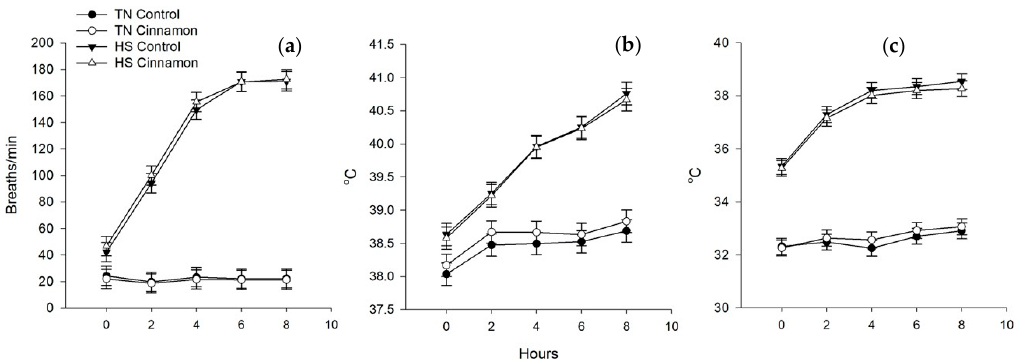
Figure 1. The effects of cinnamon (control vs. 1.5%) supplementation on thermoregulatory responses in pigs housed at 20 °C (thermoneutral, TN) or 35 °C (heat stress, HS) for 7 d. Heat stress increased ( a ) respiration rate, ( b ) rectal and ( c ) skin temperature ( p < 0.001 for all). No effects of cinnamon on thermoregulatory responses were observed.